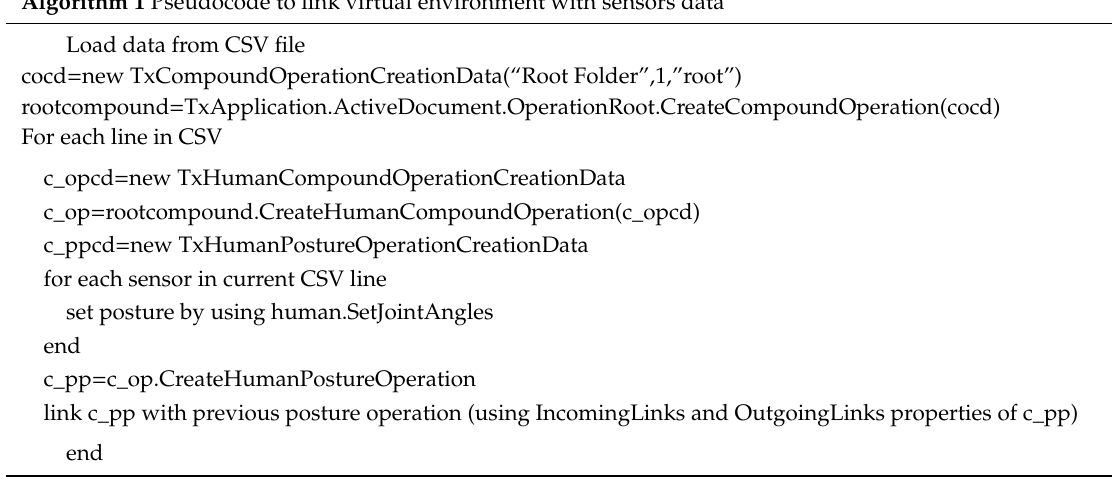
Algorithm 1 Pseudocode to link virtual environment with sensors data